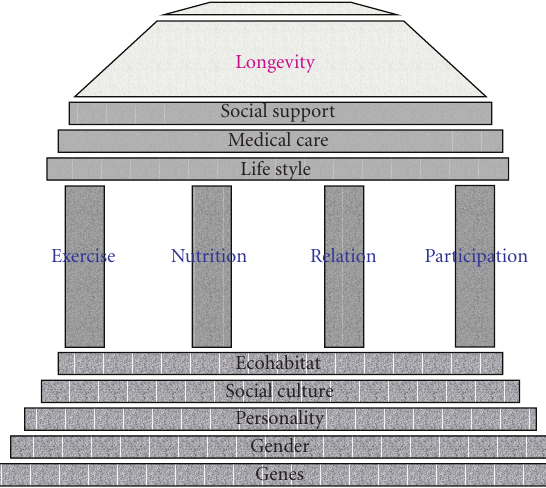
Figure 1: Park’s Temple Model of Human